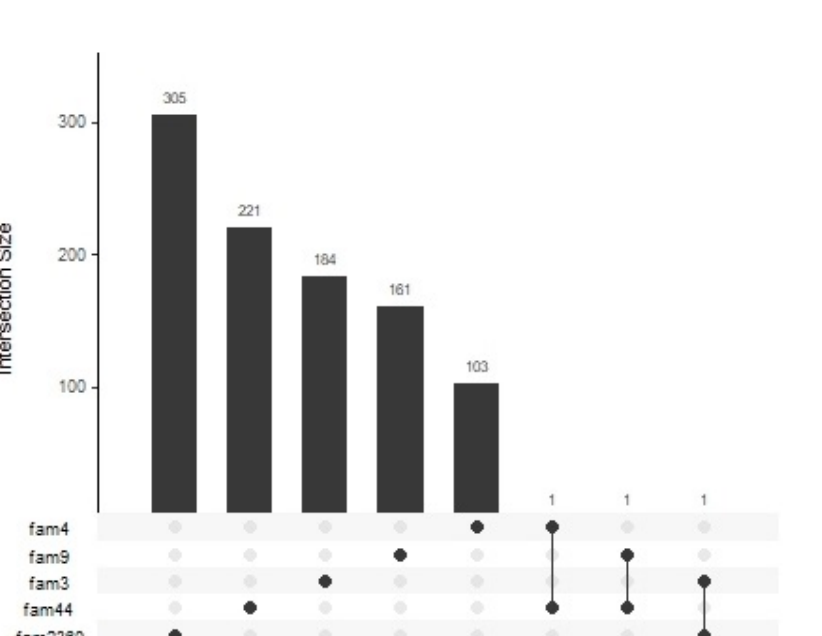
Figure 1. Upset plot. In the plot, the intersections of genes between families are visualized. The first five bar charts on the top of the figure represent the number of genes in the significant RCHHs found only in each individual family. The last three bar charts on the top of the figure report the number of genes shared between families.